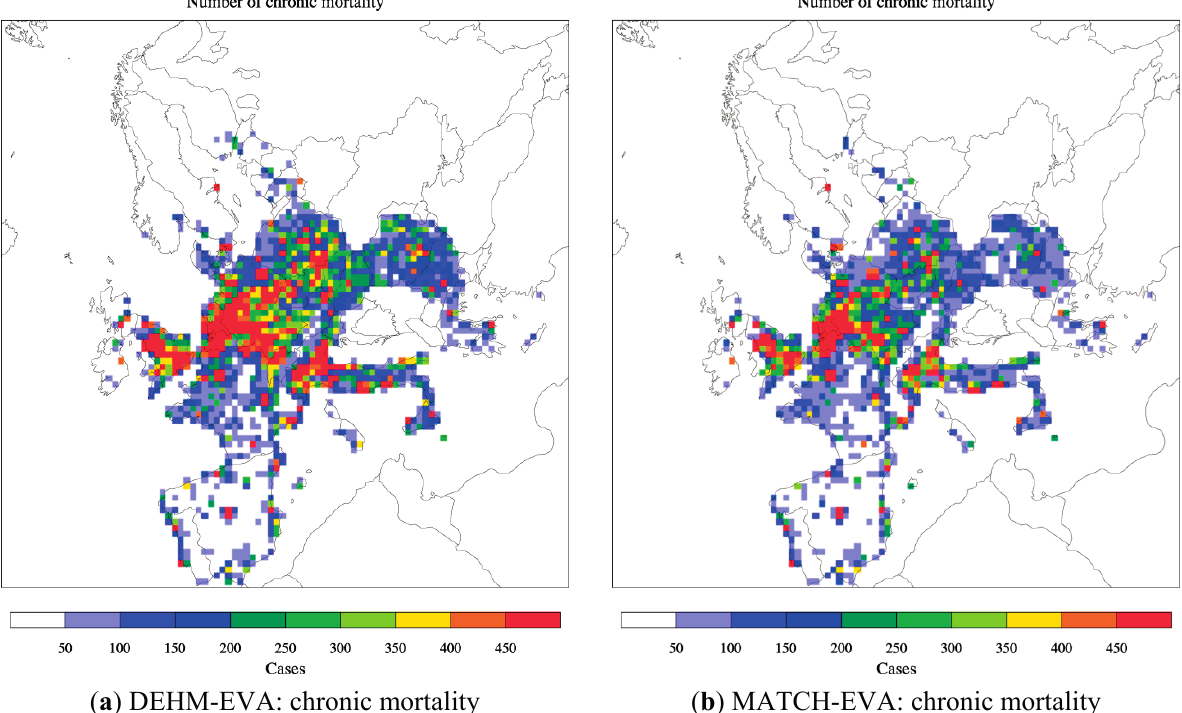
Figure 3. The spatial distribution of chronic mortality across Europe related to PM 2.5 . Based on DEHM ( a ) and MATCH ( b ) simulations with climate, emissions and population data for 2000 (the base “present day” case). The area of a grid cell is 50 km × 50 km = 2500 km 2 . The colour bar refers to number of cases per year per 2500 km 2 . See Figures 5 and 7 for the total number for Europe and the Nordic